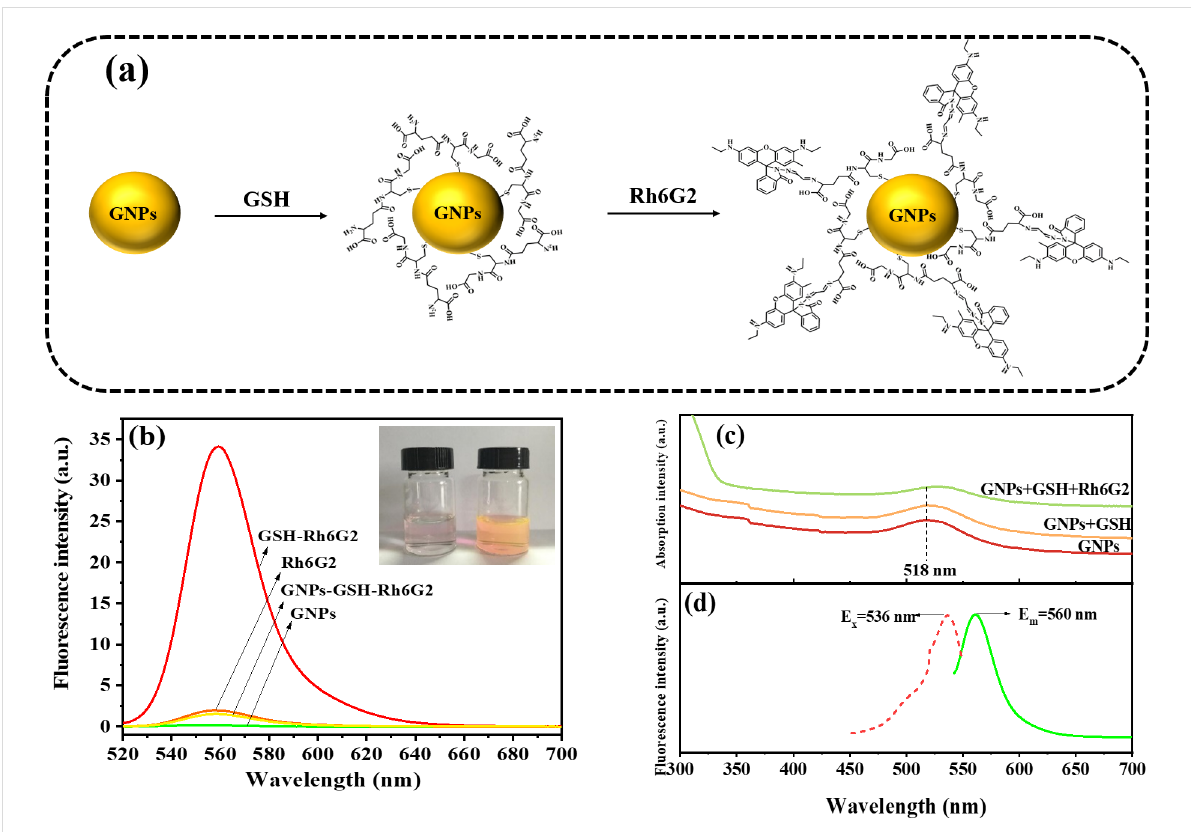
Figure 1: (a) Synthesis of functionalized GNPs-GSH-Rh6G2; (b) fluorescence spectra of GNPs, Rh6G2, GSH-Rh6G2, and GNPs-GSH-Rh6G2 (inset: the left bottle and the right bottle contain GNPs-GSH-Rh6G2 and GSH-Rh6G2, respectively); (c) UV–vis spectra of GNPs, GNPs-GSH, and GNPs- GSH-Rh6G2; (d) fluorescence excitation and emission spectra of